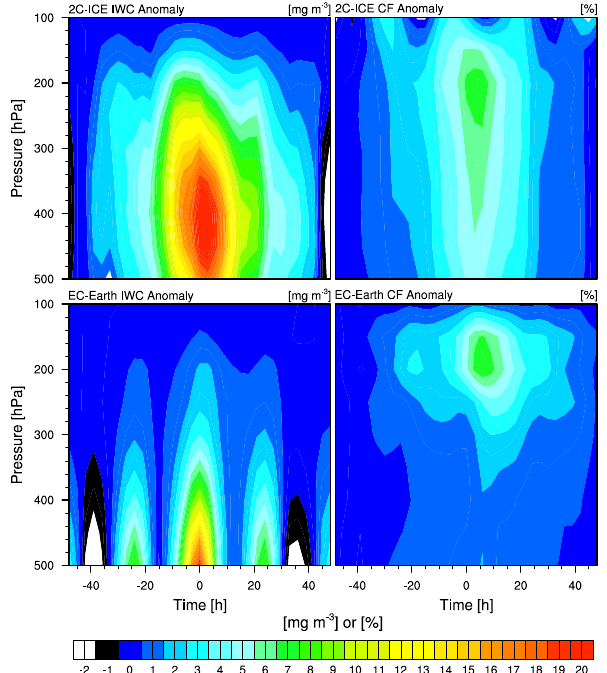
Fig. 6. Observed (top row) and modelled (bottom row) anomalies in (left column) IWC and (right column) CF, averaged over a re- gion spanning ± 3 ◦ latitude and ± 10 . 5 ◦ longitude of the composite centre point. The background state is computed in the same man- ner as Fig. 5. The 2C-ICE plots are smoothed used a running mean window of